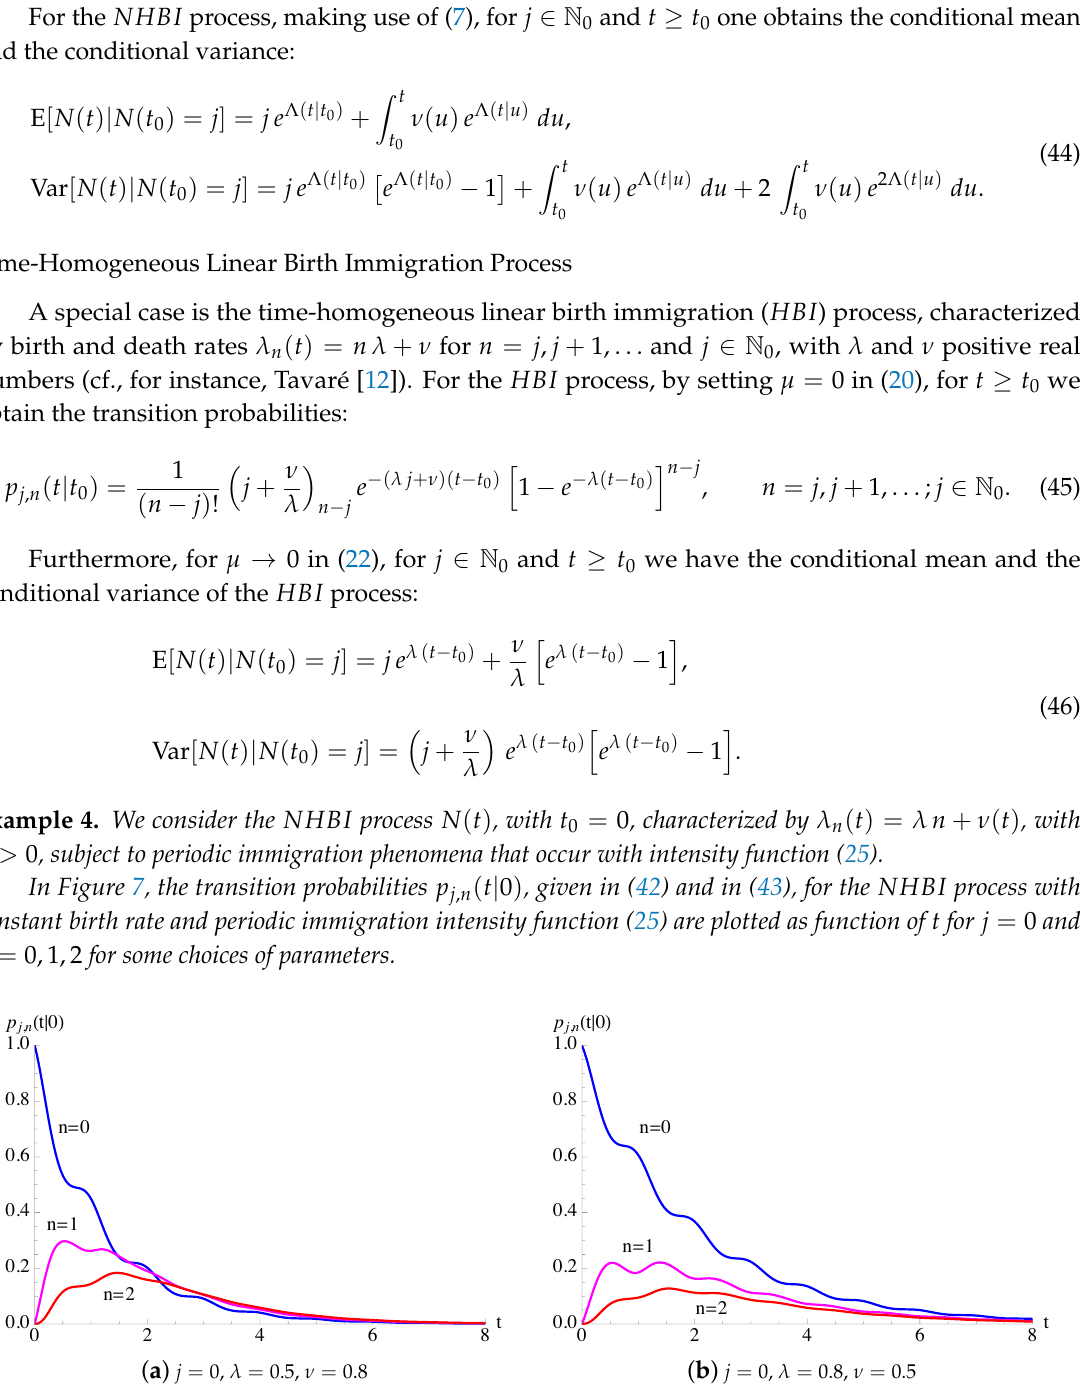
Figure 7. For the NHBI process, having λ n ( t ) = λ n + ν ( t ) , with ν ( t ) given in (25), the probabilities p j , n ( t | 0 ) are plotted for a = 0.9, Q = 1.0 with n =